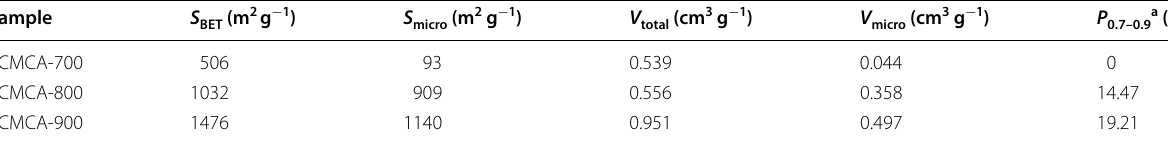
a Percentage of the pores distributed between 0.7 and 0.9 nm